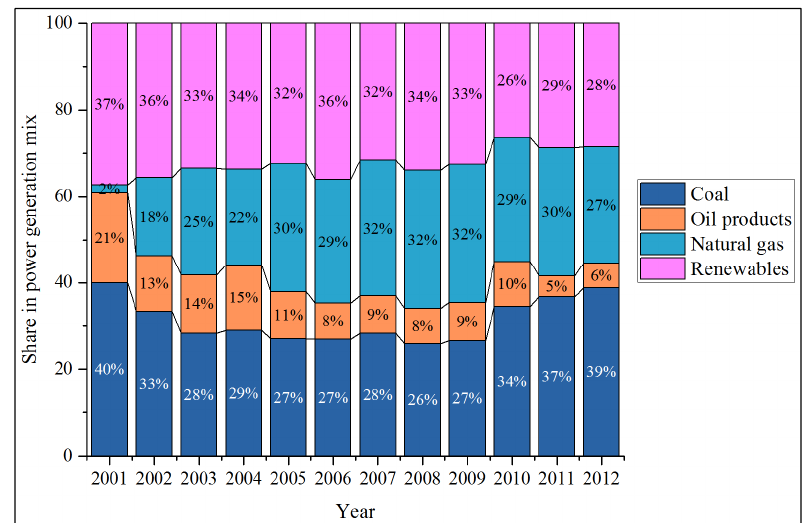
Figure 16. The Philippines: power generation